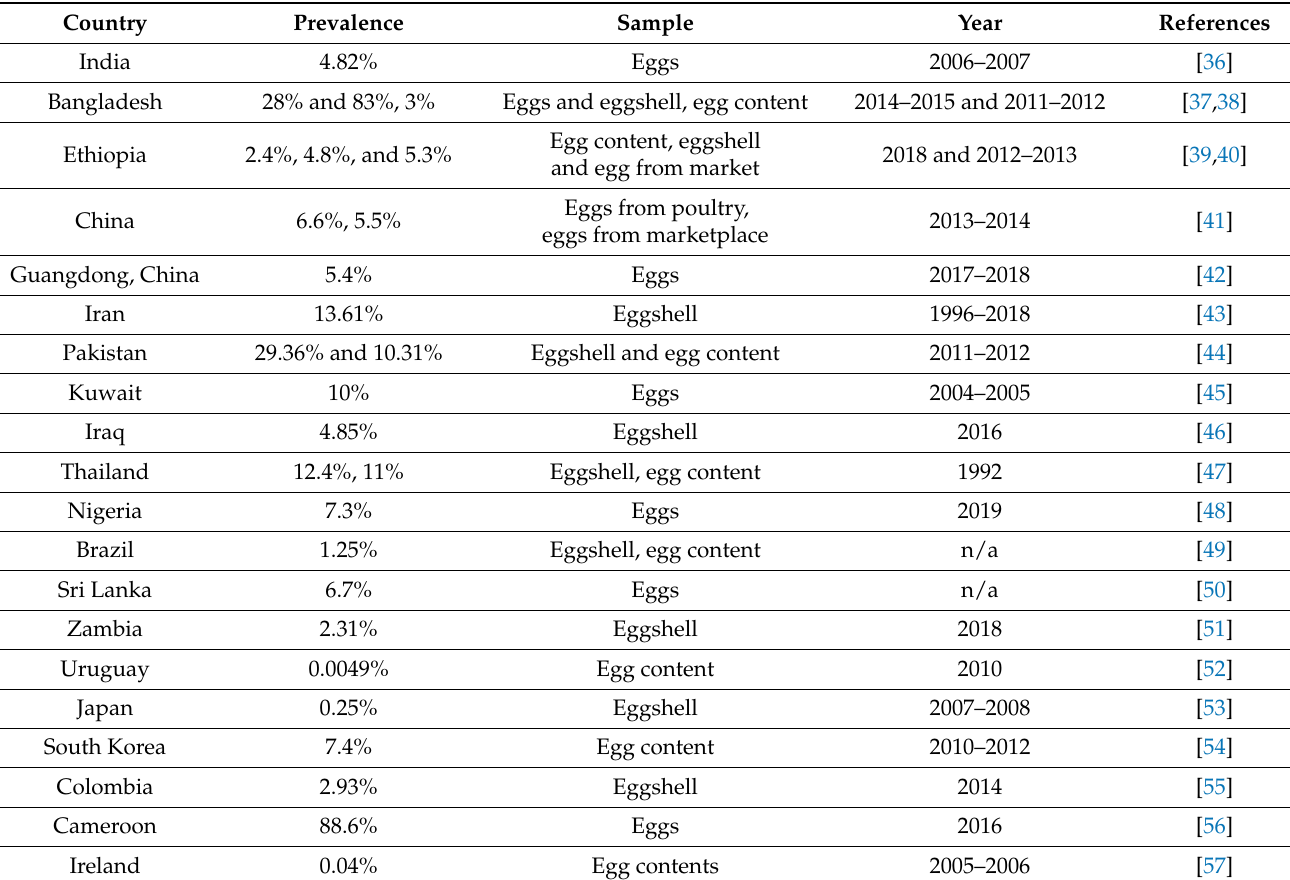
Table 1. Prevalence of Salmonella spp. in eggs in different